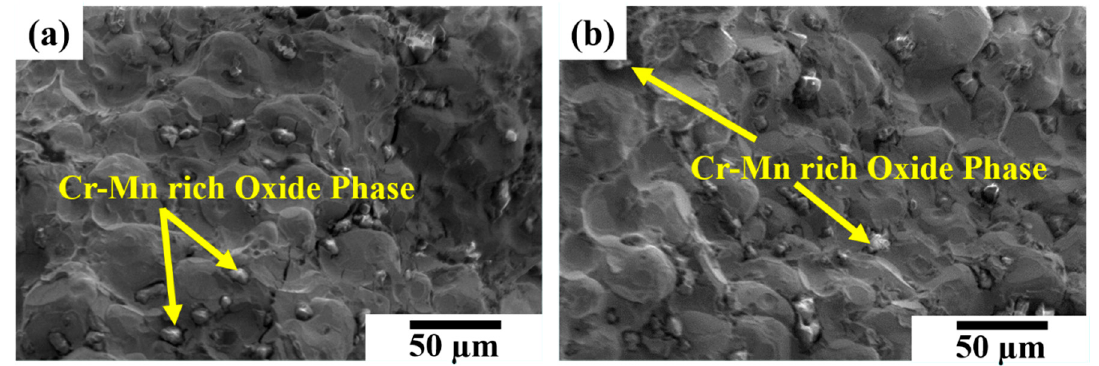
processes). processes).